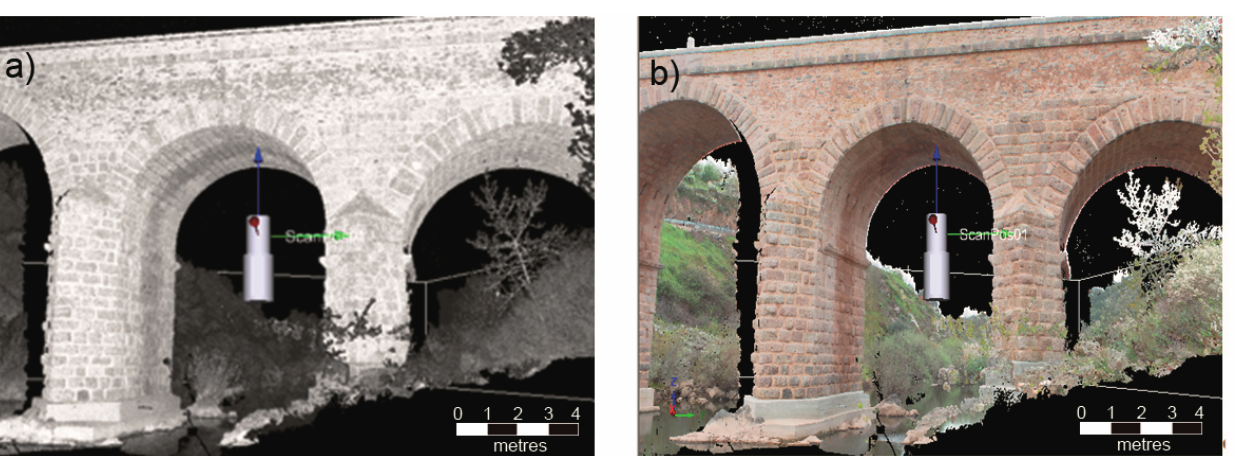
Figure 4. Visualization of a 3D point cloud as a function of ( a ) the intensity of the reflected laser beam or ( b ) the photorealistic texture of the